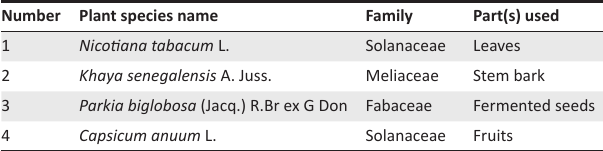
TABLE 7: Names of plants and their parts used for the formulation of traditional oral powdered herbal formulations for the treatment of convulsion in Ogbomoso, Nigeria.